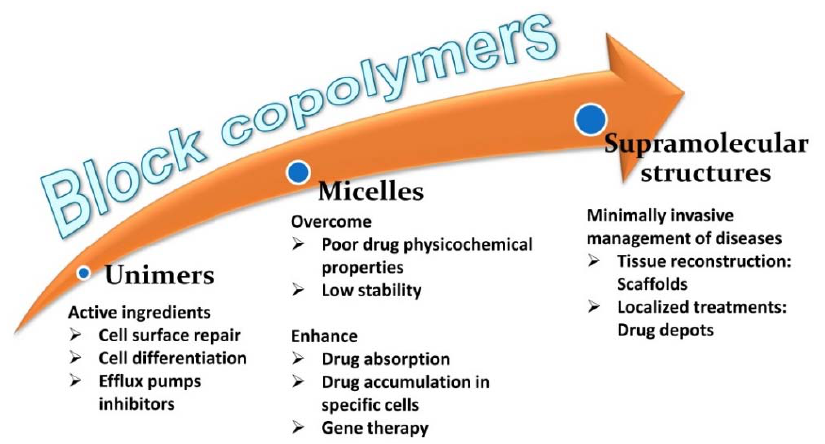
Figure 2. The evolution of the structure of block copolymers. Some advantages of the use of polymeric micelles and supramolecular structures.